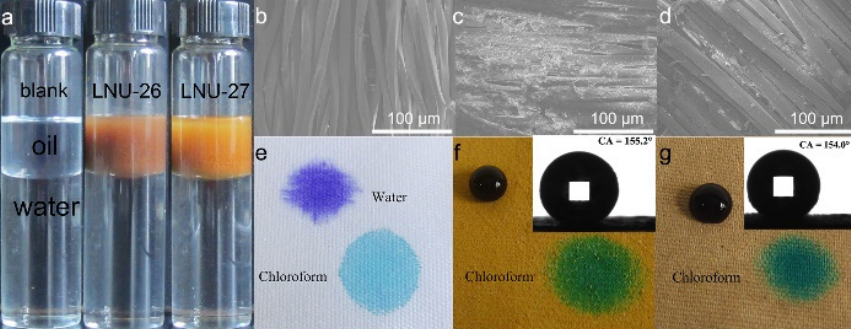
Figure 3. ( a ) Photograph of PAF solids dispersed in a kerosene/water mixture; SEM images of ( b ) raw polyester fabric, ( c ) LNU-26- and ( d ) LNU-27-coated fabric; comparison diagram of water and chloroform droplets on ( e ) raw polyester fabric, ( f ) LNU-26-, and ( g ) LNU-27-coated fabric; inset: WCA of ( f ) LNU-26- and ( g ) LNU-27-coated fabric.